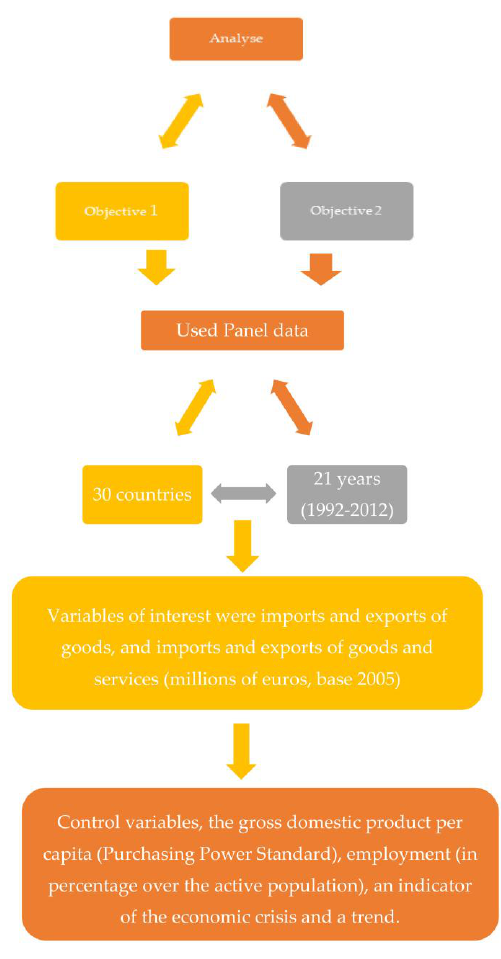
Figure 3. The model.